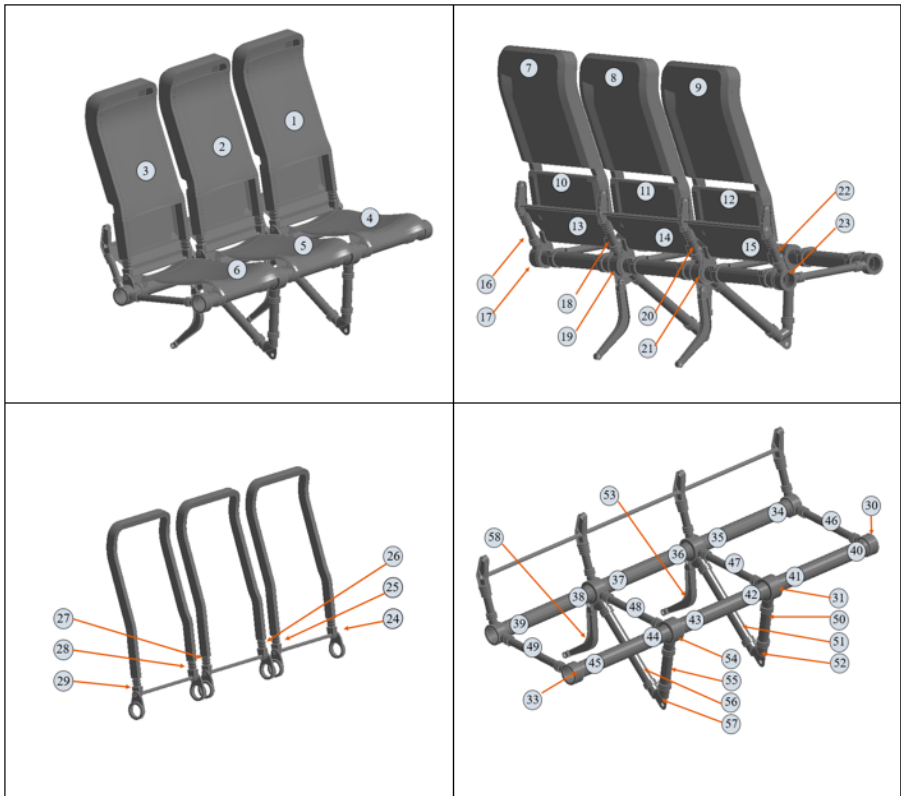
Figure 10. Numbering of the primary loading path components.